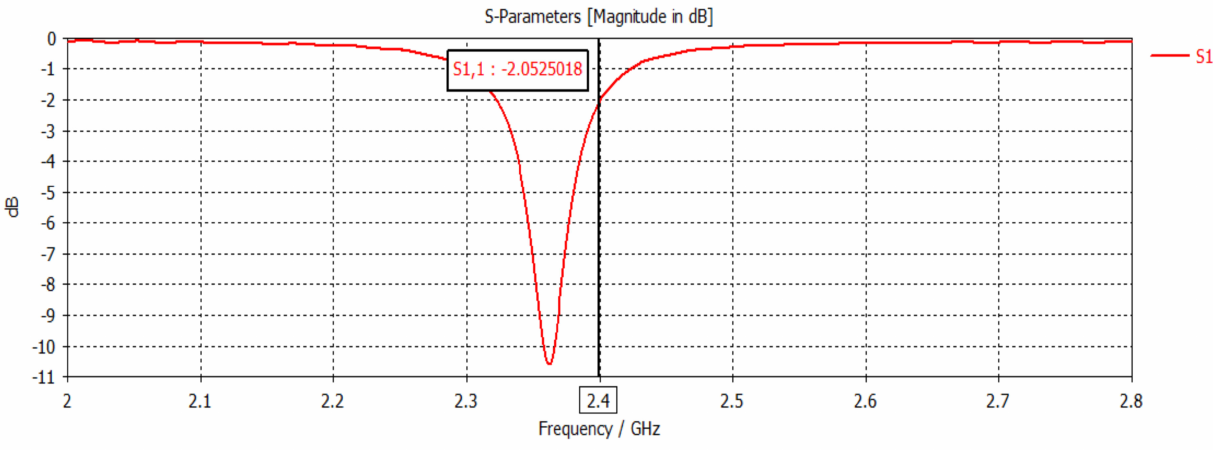
Figure 11. S11 parameter by frequency in patch antenna of 2.4 GHz with line transmission λ /4.